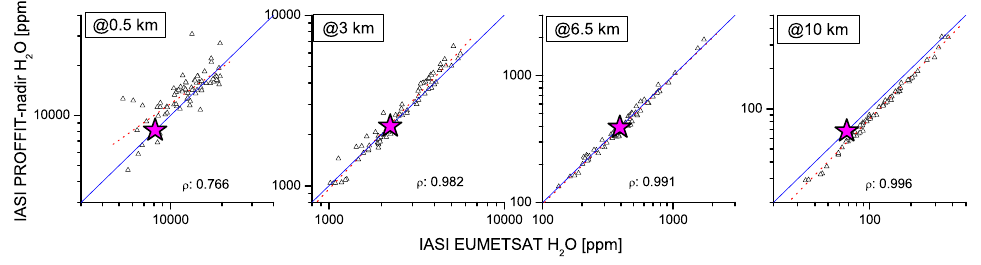
Fig. 10. Correlation plots between PROFFIT-nadir and EUMETSAT IASI H 2 O data. From the left to the right for 0 . 5 , 3 , 6 . 5 , and 10 km altitude. The magenta stars indicate the applied a priori values.